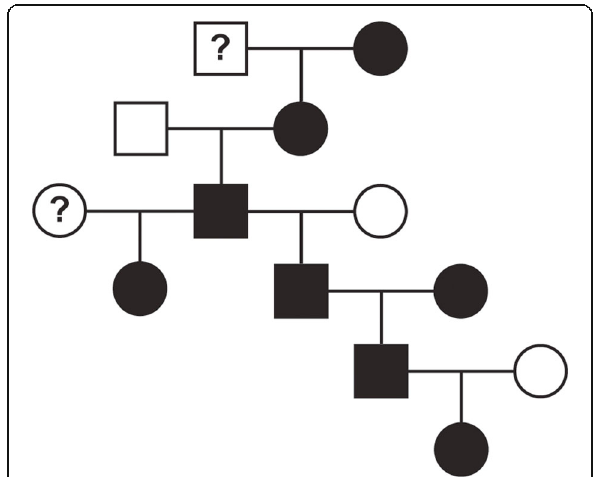
Fig. 1 An Irish Wolfhound family pedigree that supports a dominant mode of inheritance for atrial fibrillation. Square = male. Circle = female. White = no atrial fibrillation over eight years of age. Black = diagnosed with atrial fibrillation at any age. Question mark = no cardiac phenotype information available to classify as affected or